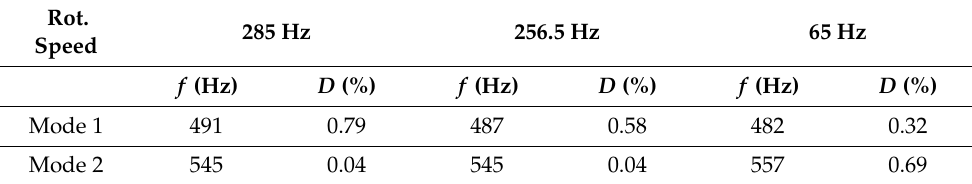
Table 2. Selected, robust eigenfrequencies in operation